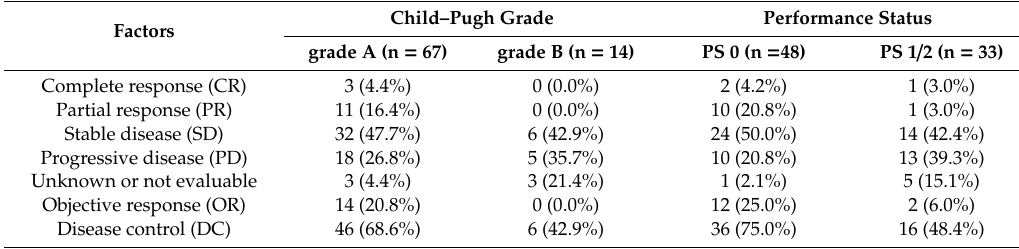
Table 4. Summary of efficacy measures according to RECIST stratified by Child–Pugh grade and performance status.